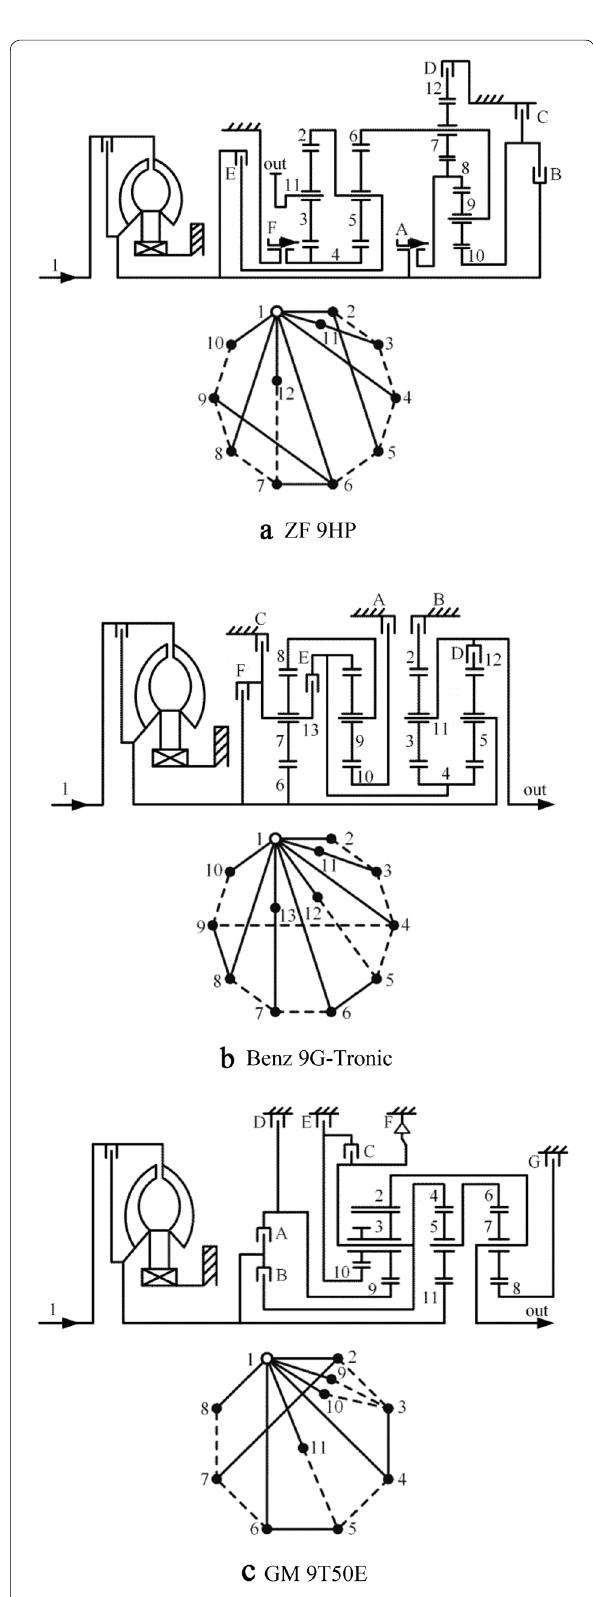
Figure 2 Structure diagrams of different ATs and the corresponding